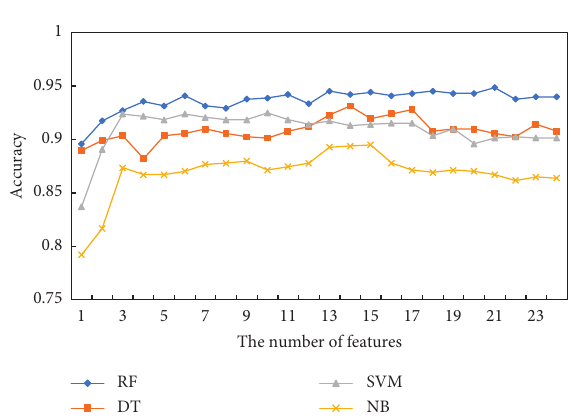
Figure 3: Based on the new